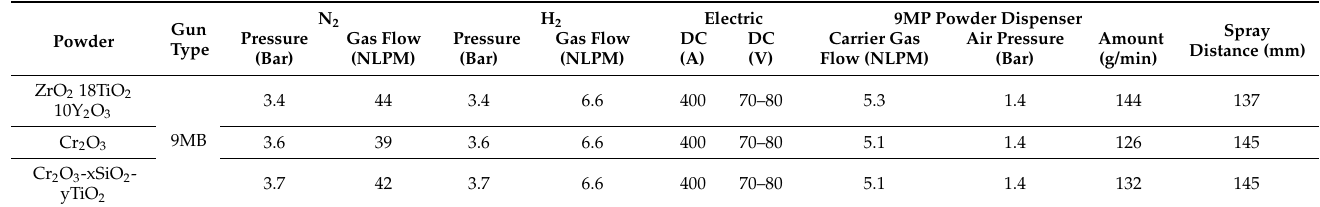
Table 1. Technological parameters used during the counting process.